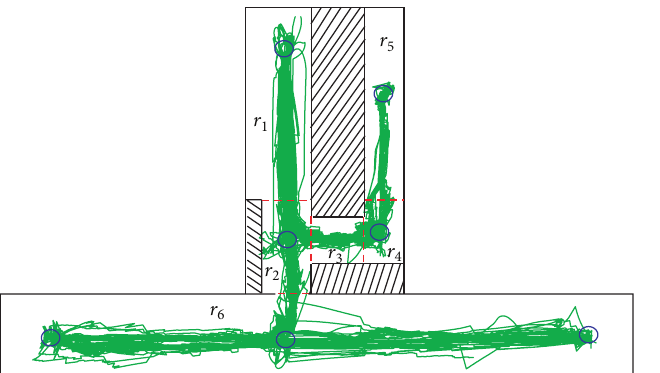
Figure 15: Trajectory followed by the robot (green lines) during experiment 3. Black lines represent forbidden space. Red dashed lines represent the boundaries of the regions (see [24] for more details).